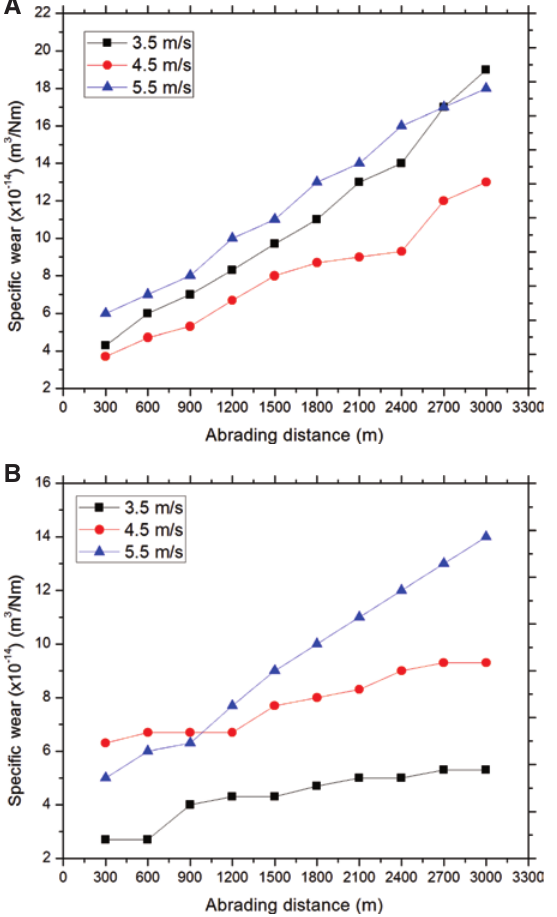
Figure 12 Effect of sliding velocity on coefficient of friction, run at 30 N load: untreated composites (A) and alkali-treated composites